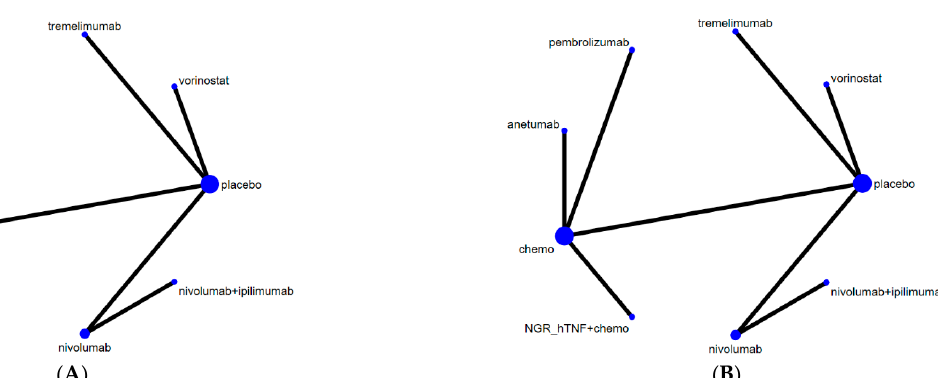
Figure 2. Network constructions for comparisons of overall survival (OS) and progression-free survival (PFS). ( A ) Network constructions for the comparison of OS (based on hazard ratios (HRs)). ( B ) Network constructions for the comparison in PFS (HR).